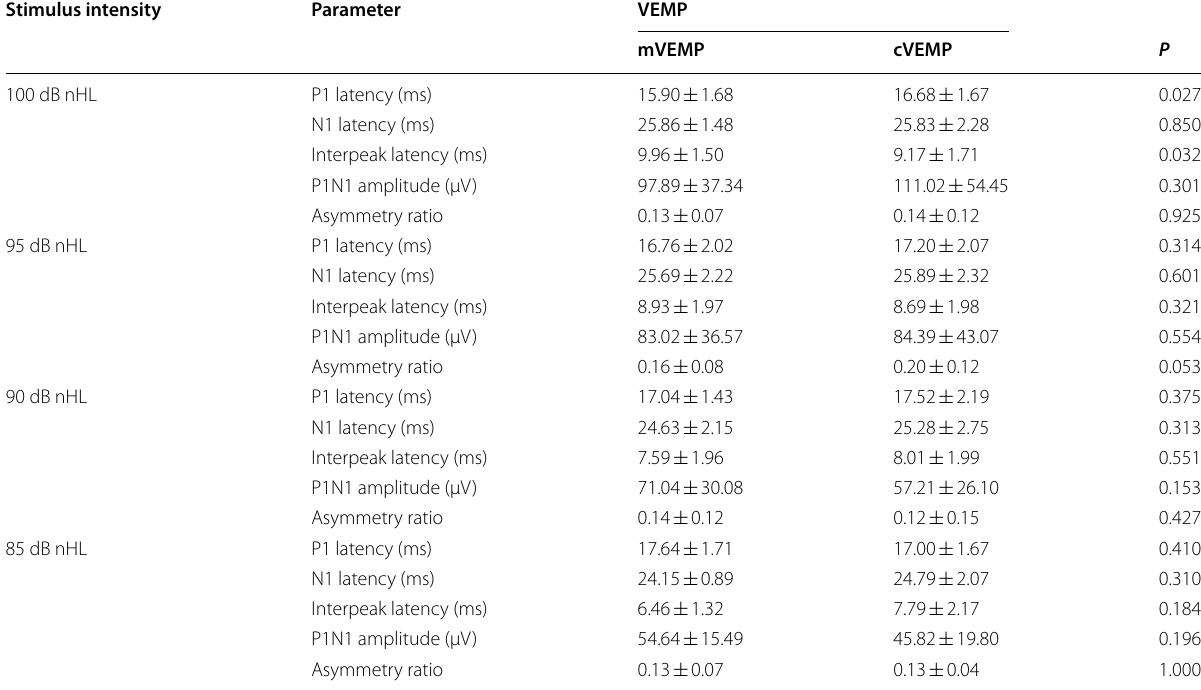
Table 3 Comparison of mVEMP and cVEMP measurement parameters Stimulus